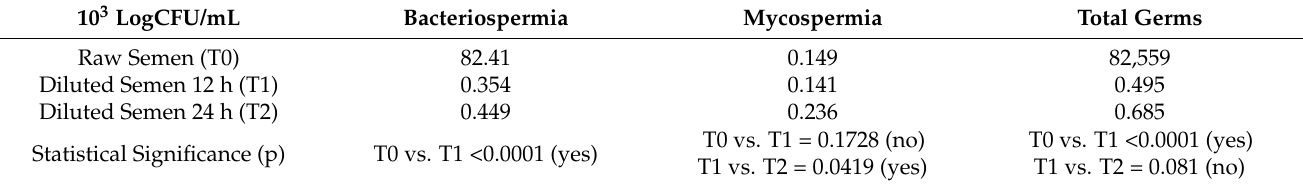
Table 1. Microbiological load (bacterial and fungal) of boar semen at the time of ejaculate collection (raw semen T0), 12 h after dilution (T1) and 24 h after dilution and storage at 17 ◦ C. 10 3 LogCFU/mL